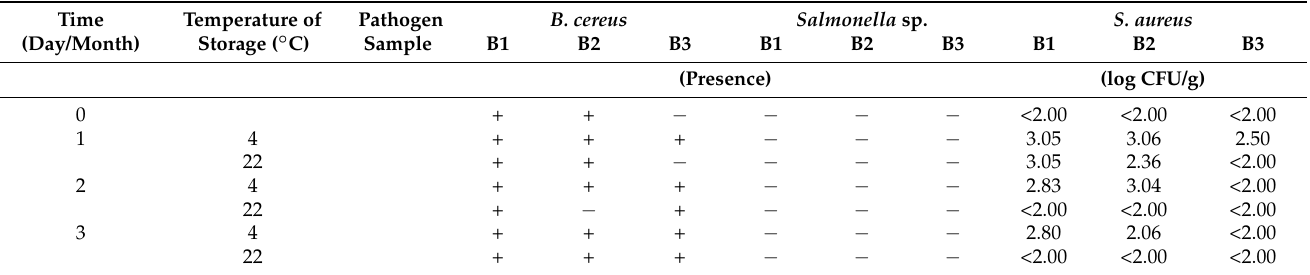
Table 2. Evaluation of the presence of pathogenic bacteria in the tested products.